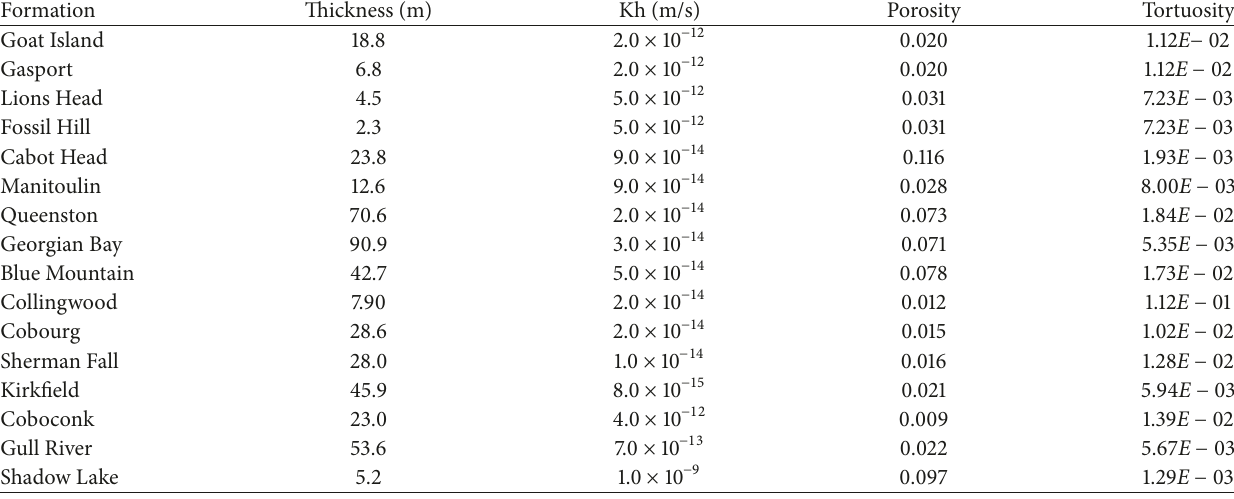
Table 1: Summary of formation input parameters for calibration of numerical models. Adapted from Sykes et al. [37]. Formation